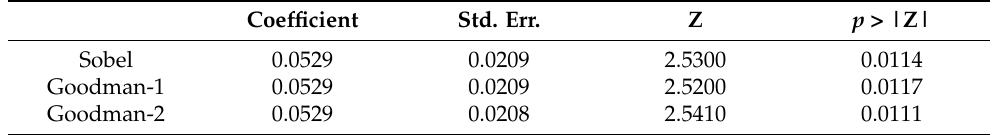
Table 8. Sobel test